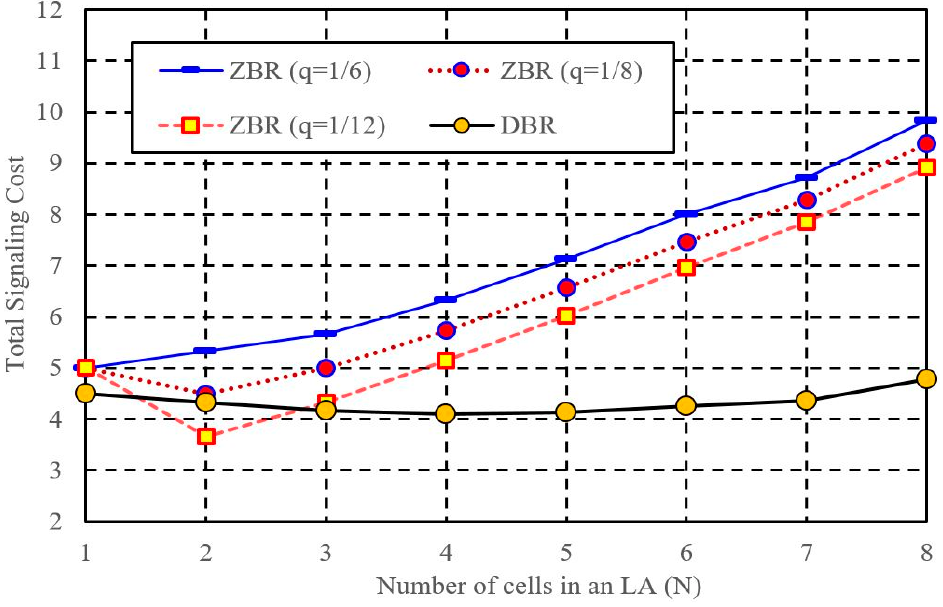
Figure 17. Performance comparison results of DBR and ZBR (CMR = 1, U = 4).